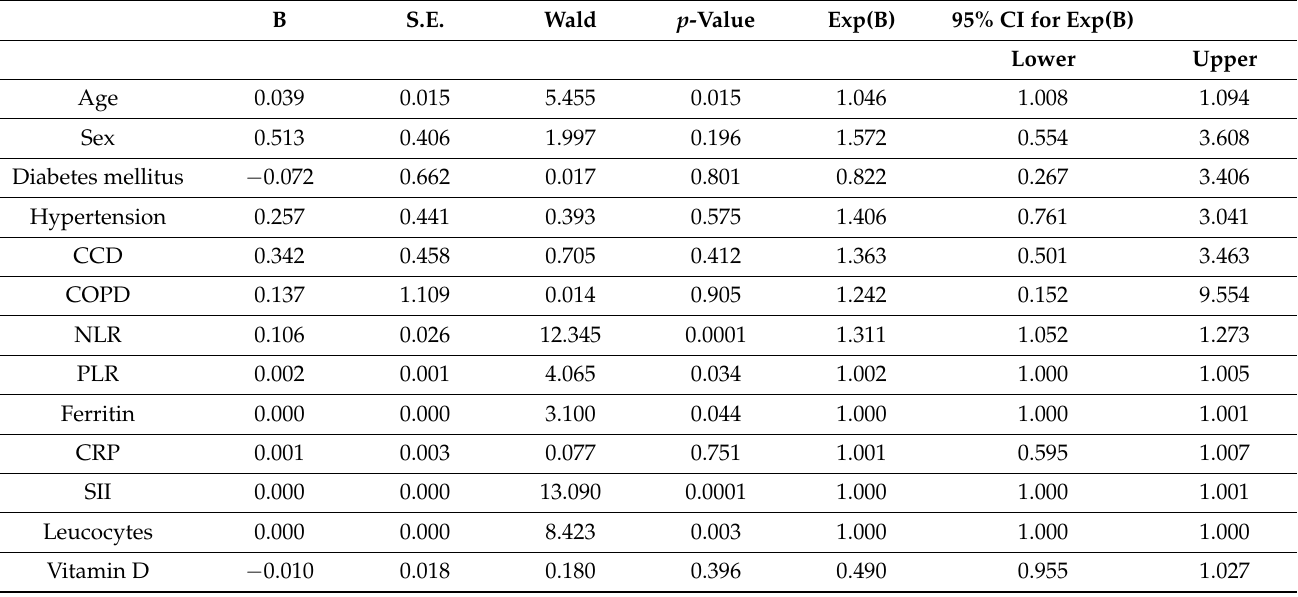
Table 5. The relationship for the in-hospital mortality with demographic parameters, vitamin D status, and inflammatory biomarkers.